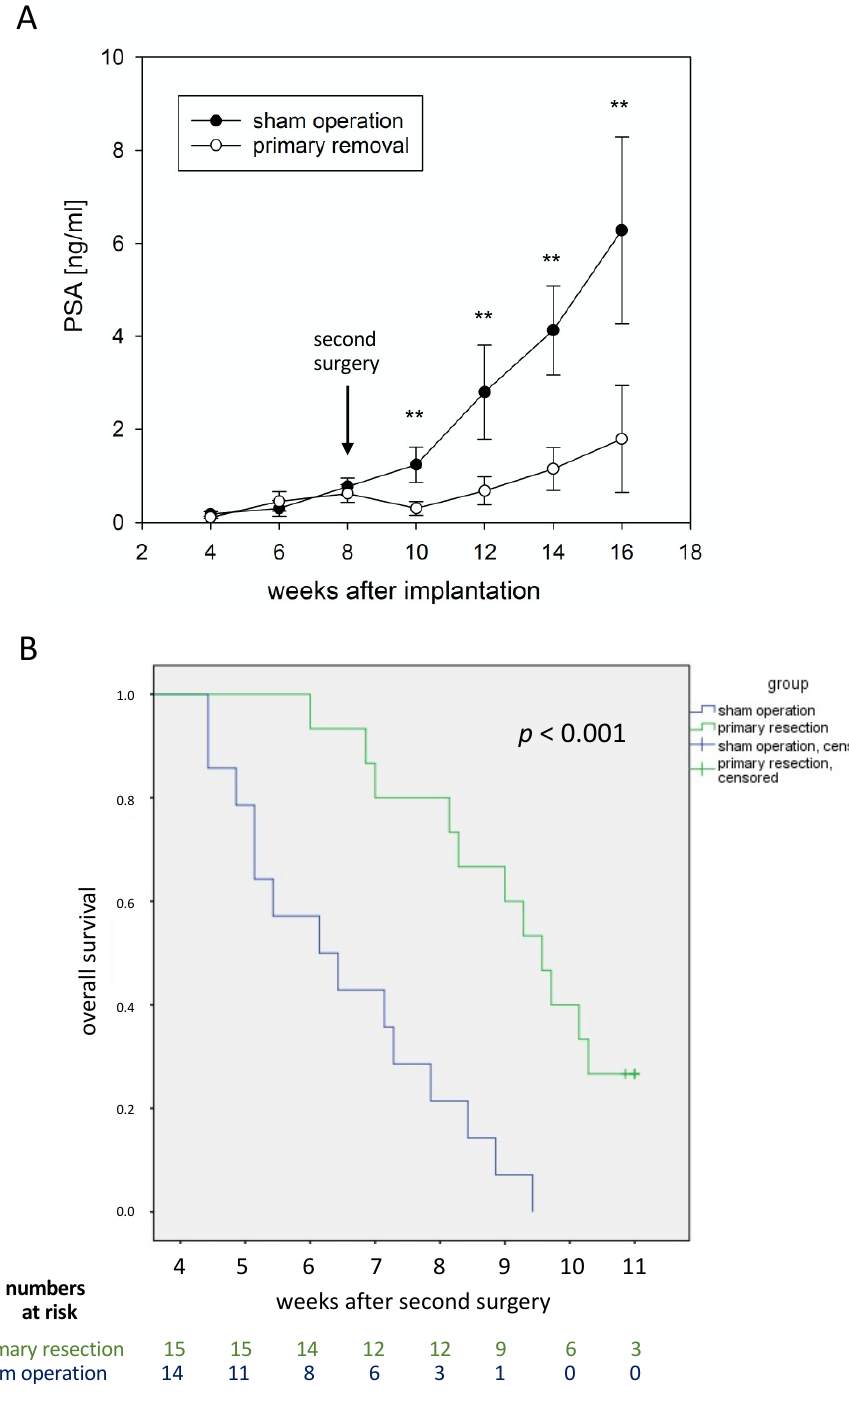
Figure 4. PSA progression and survival after cytoreductive primary tumor resection. ( A ) Develop- ment of PSA values in the serum of mice (retrieved by puncture of the retrobulbar venous plexus) after sham operation (black dots) and after primary tumor resection (white dots). The medians and standard deviations for all mice still alive at the respective time point in each group are shown. ( B ) Kaplan–Meier curves illustrating the survival of mice after sham operation (blue curve) or primary tumor resection (green). Of note, the last surviving animals were sacrificed a few days later than week 18, thus explaining the presence of the time point “11 weeks” in this Kaplan-Meier curve. The p -value in the graph was calculated using a log-rank test. ** p < 0.01.